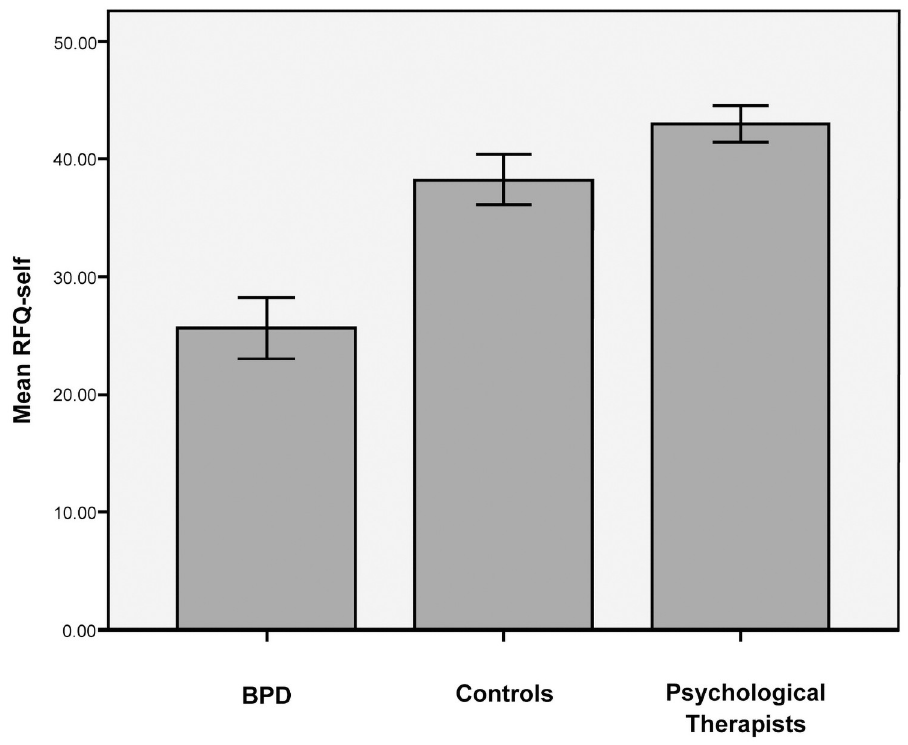
Fig 1. RFQ-self: Comparing means between groups. Error bars: 95% CI.